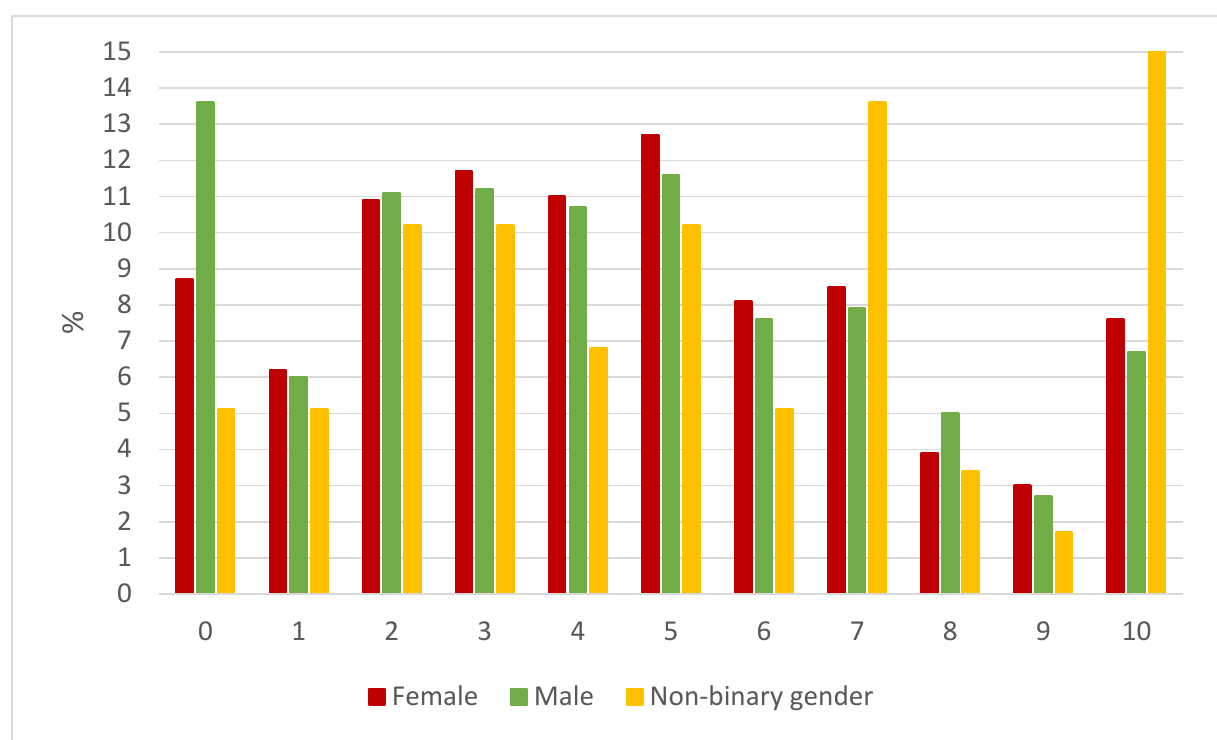
Figure 1. The overall impact of the COVID-19 outbreak on adolescents. Adolescents rated the overall impact of COVID-19 on their life on a numeric analogue scale, between 0 “slightly or no affect” and 10 “has affected me immensely”. The self-reported impact of COVID-19 restrictions on young people’s everyday lives has differed depending on the nationality of the respondents (Figure 2). The highest impact (median at eight) was reported from students from the USA; importantly, this sample is not representative of the USA and is the smallest in our study. In the other four countries (Sweden, Morocco, Serbia, Vietnam), the median was five or below. With a comparable number of respondents, we had responses from Sweden, Serbia, and Vietnam. Among these three countries, Swedish adolescents reported the lowest impact on their everyday life by COVID-19 (Figure